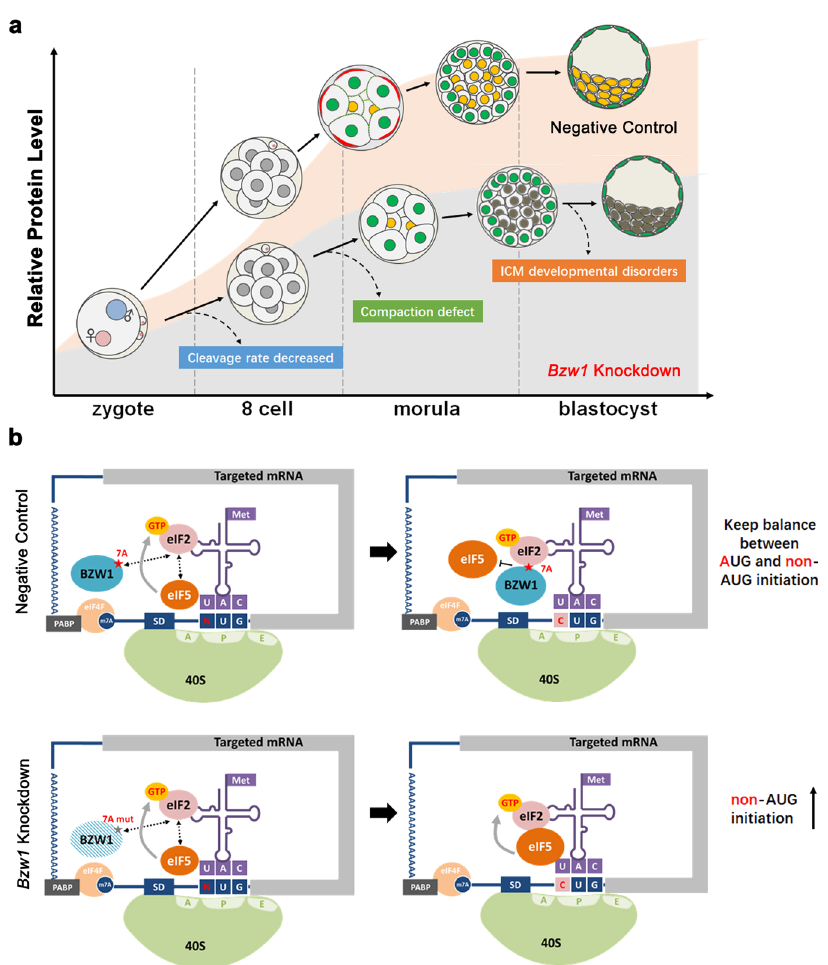
Fig. 8 | BZW1 can regulate preimplantation embryonic development and total protein levels by restricting non-AUG translation initiation. a BZW1 is required forensuretotalproteinsynthesisduringearlyembryonicdevelopment.Thelackof BZW1 decreased the rate of early embryo cleavage. The Bzw1 RNAi embryos that reachedthe8-cellstagefailedtodevelopintothemorulastage.Asmallproportion of Bzw1- knockdownembryosdevelopedtotheblastocyststage,butwithabnormal